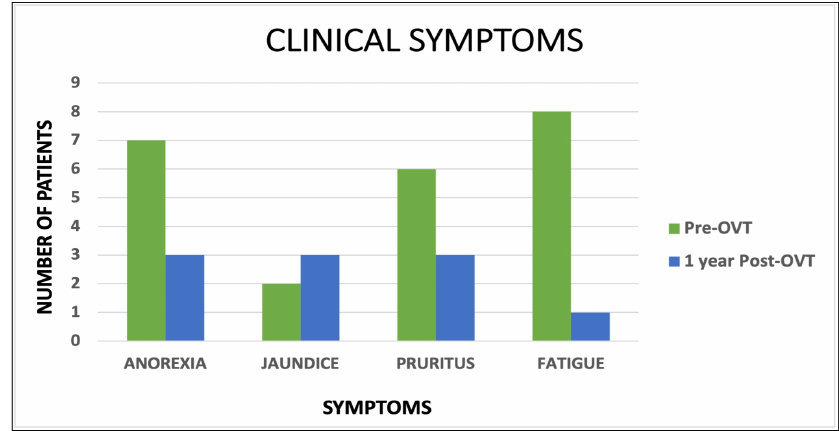
Figure 1. Clinical symptoms before oral vancomycin therapy (OVT) and one-year